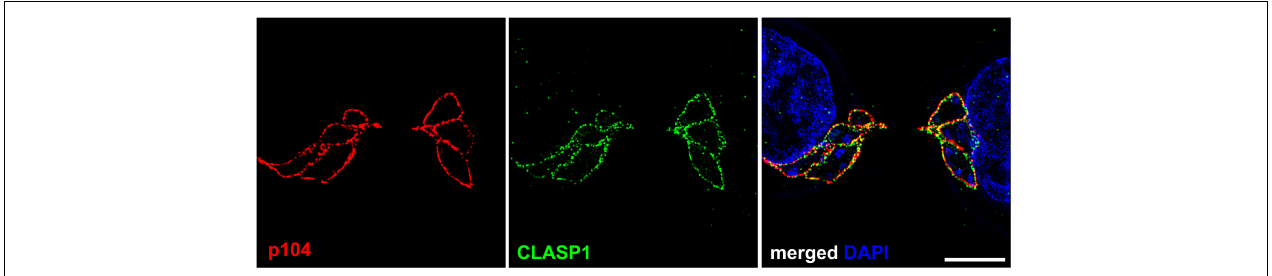
FIGURE 1 | Punctate localization of Theileria annulata p104 and bovine CLASP1 on the schizont membrane. Structured illumination microscopy (SIM) was performed on T. annulata infected macrophages (TaC12) with anti-p104 (red) and anti-CLASP1 (green) antibodies. Z -stack images were taken at 12.5 nm intervals, one z -stack is shown. Scale bar is 5 µ